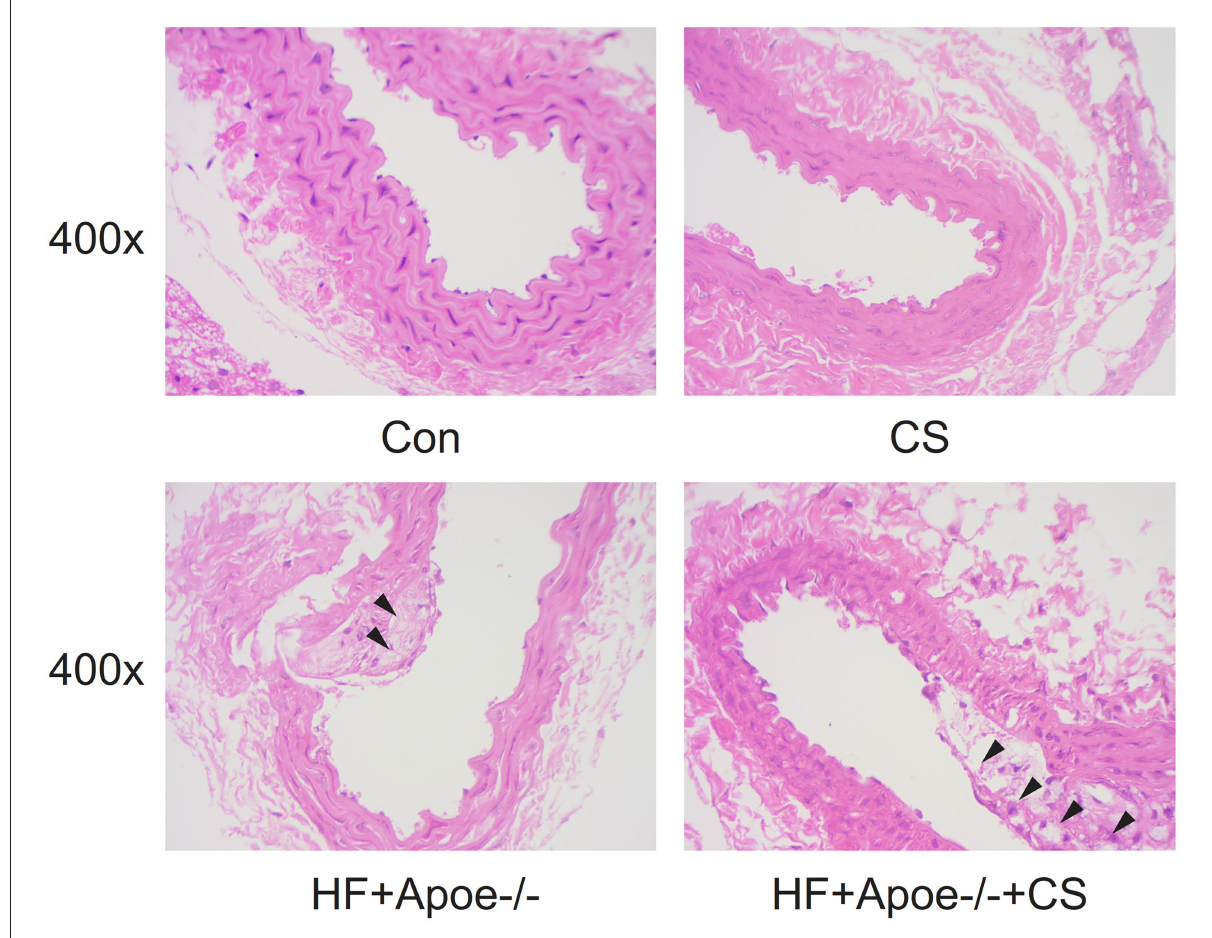
FIGURE3 Pathological observation of the normal artery and atherosclerosis based on HE